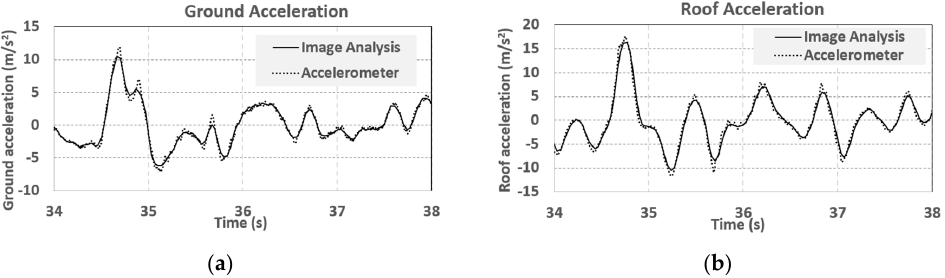
Figure 20. Acceleration histories from accelerometers and image analysis. High–frequency noise could be generated by estimating acceleration based on image measurement. (a ) Ground acceleration. (b ) Roof acceleration.